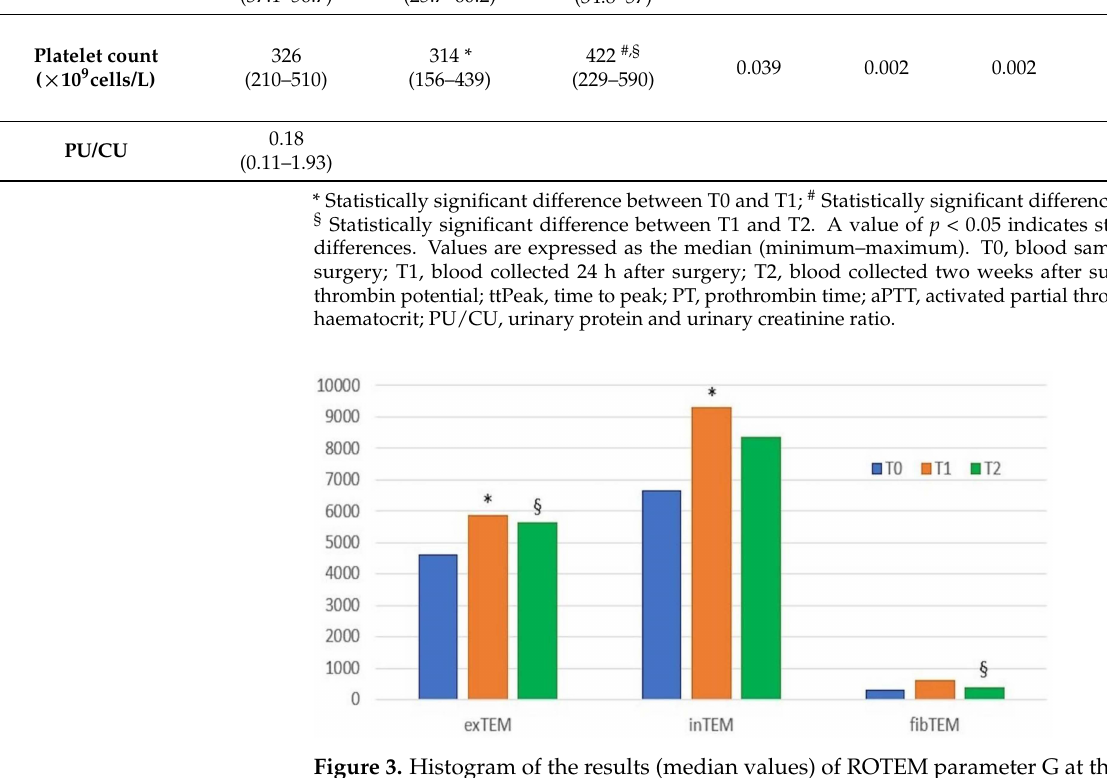
Figure 3. Histogram of the results (median values) of ROTEM parameter G at the three time points. T0, blood samples collected before surgery; T1, blood collected 24 h after surgery; T2, blood collected two weeks after surgery; * statistically significant differences between T0 and T1; § statistically significant differences between T1 and T2. A value of p < 0.05 indicates statistically significant differences. In-TEM, intrinsic thromboelastometry pathway; ex-TEM, extrinsic thromboelastometry pathway; fib-TEM, functional fibrinogen; CT, clotting time; CFT, clot formation time; MCF, maximum clot firmness; G = 5000 × MCF/(100 −